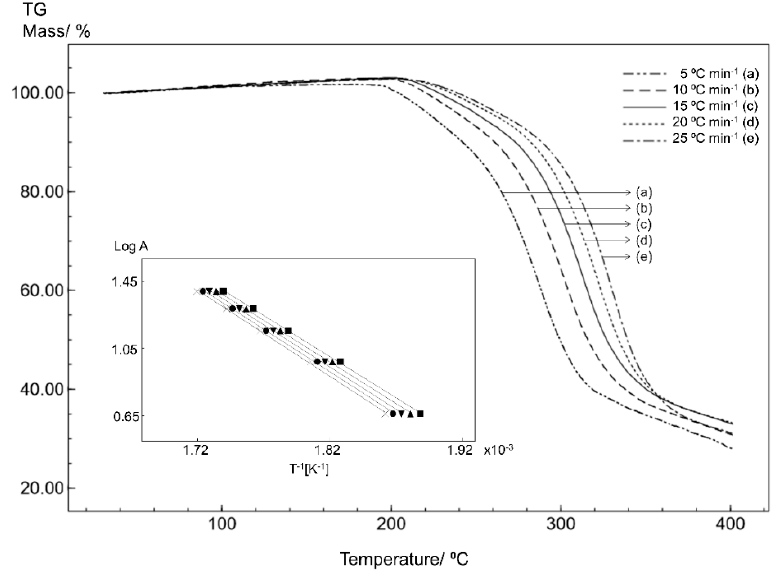
Figure 9. The TG curves for STGA obtained for different heating rates with a synthetic air atmosphere (50 mL min − 1 ). The inset shows the linear tendency of the correlation curves applying the Ozawa method.